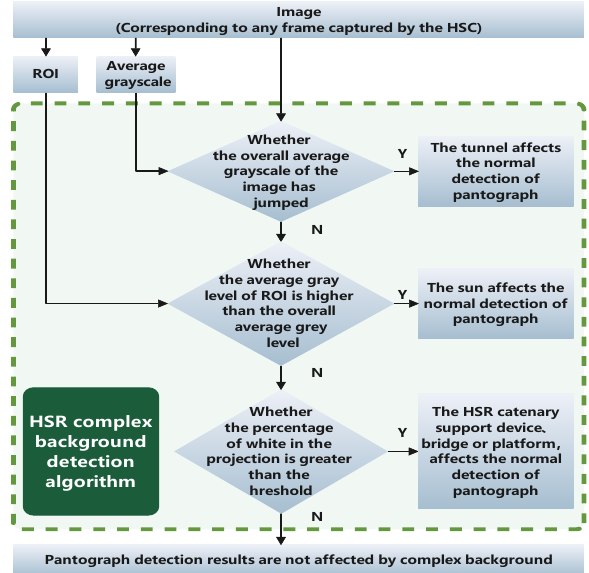
Figure 26. HSR complex background detection algorithm process flow chart.